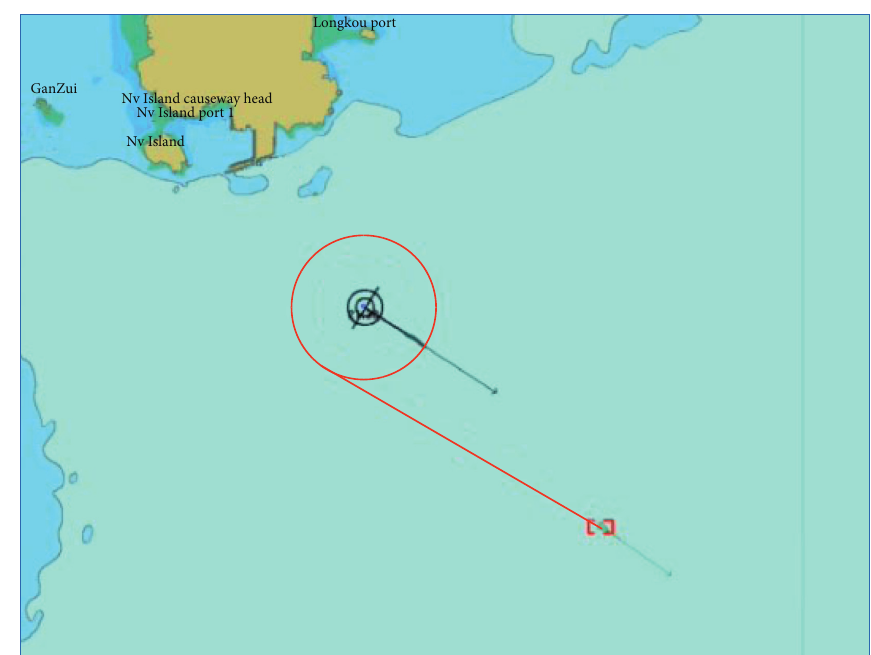
Figure 21: Own ship is overtaking